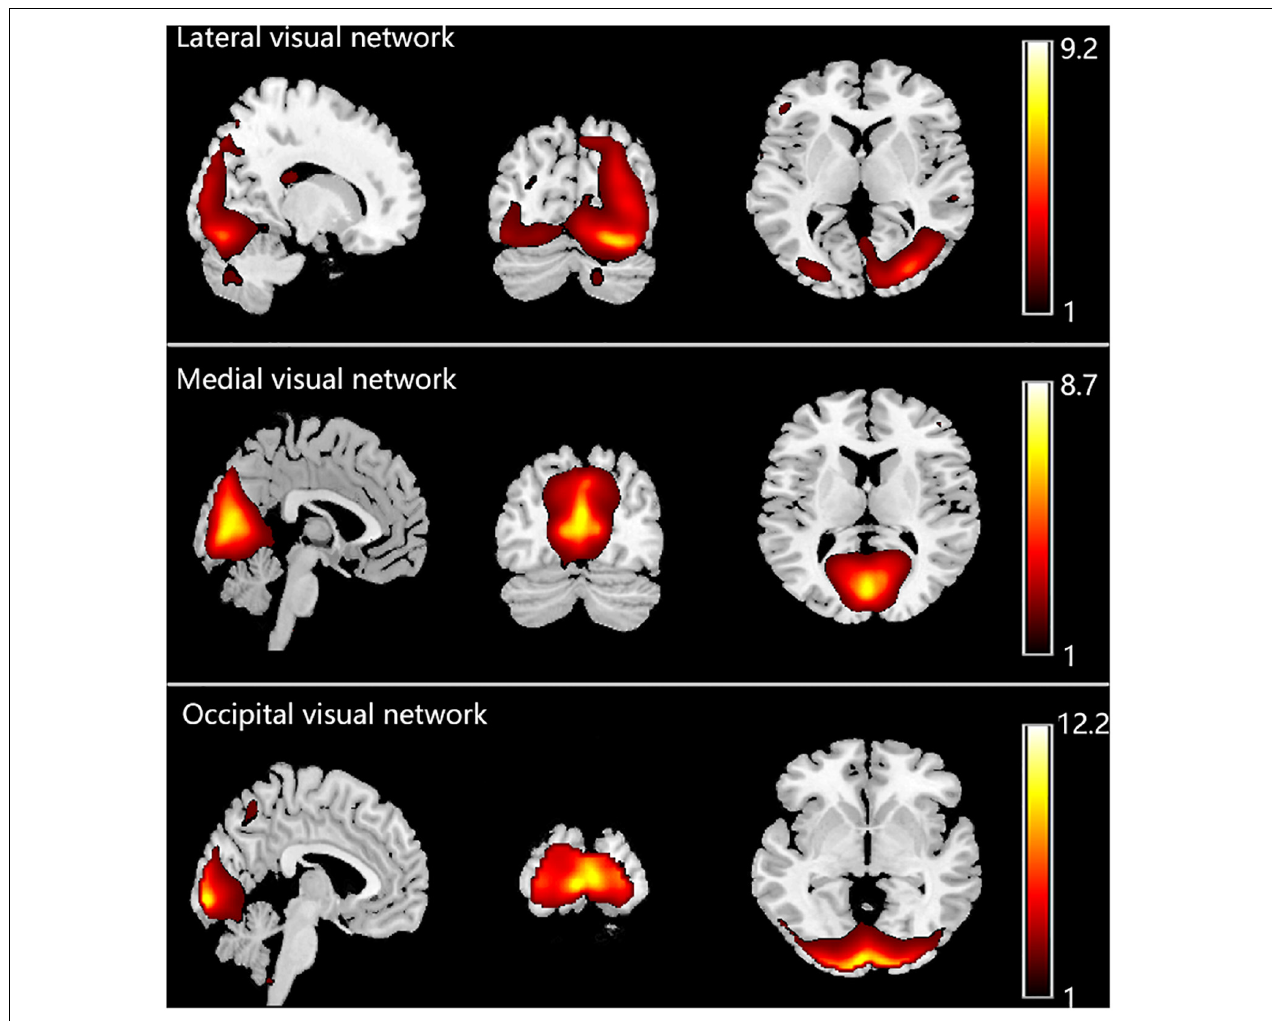
FIGURE 1 | Three visual networks identified in the enrolled 56 subjects.